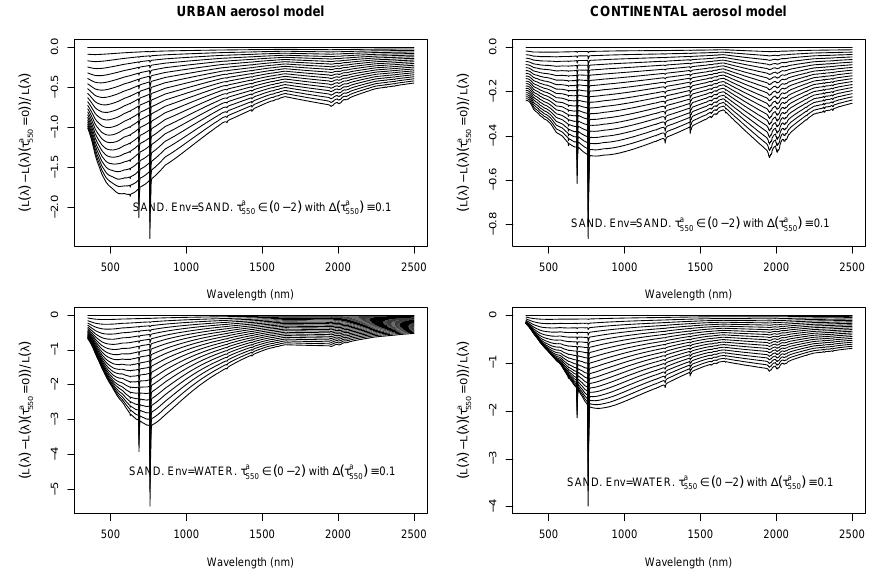
Fig. 4. δL = (L(λ) − L 0 (λ))/L(λ) with τ a 550 ∈ 0 . 0 , 2 . 0 with ∆ τ a 550 = 0 . 1 using the urban (first column) and continental (second column) aerosol models to view sand surrounded by sand, δL ss ( λ ) (first row) and water, δL sw ( λ ) (second row).